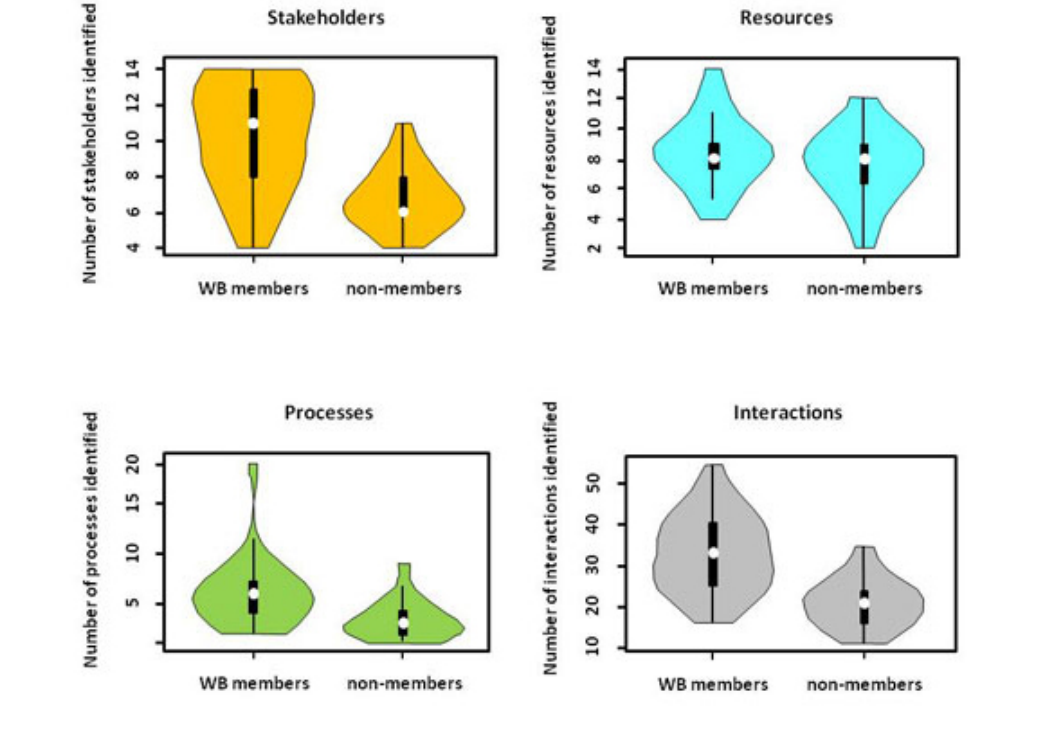
Fig. 5 . Violin plots of the number of stakeholders, resources, processes, and interactions identified by members (WB) and by nonmembers of the Water Board. The white dot represents the median value, and the black bar the 20th to 80th percentiles of the data. The different colored ellipses represent the probability density of the data at different